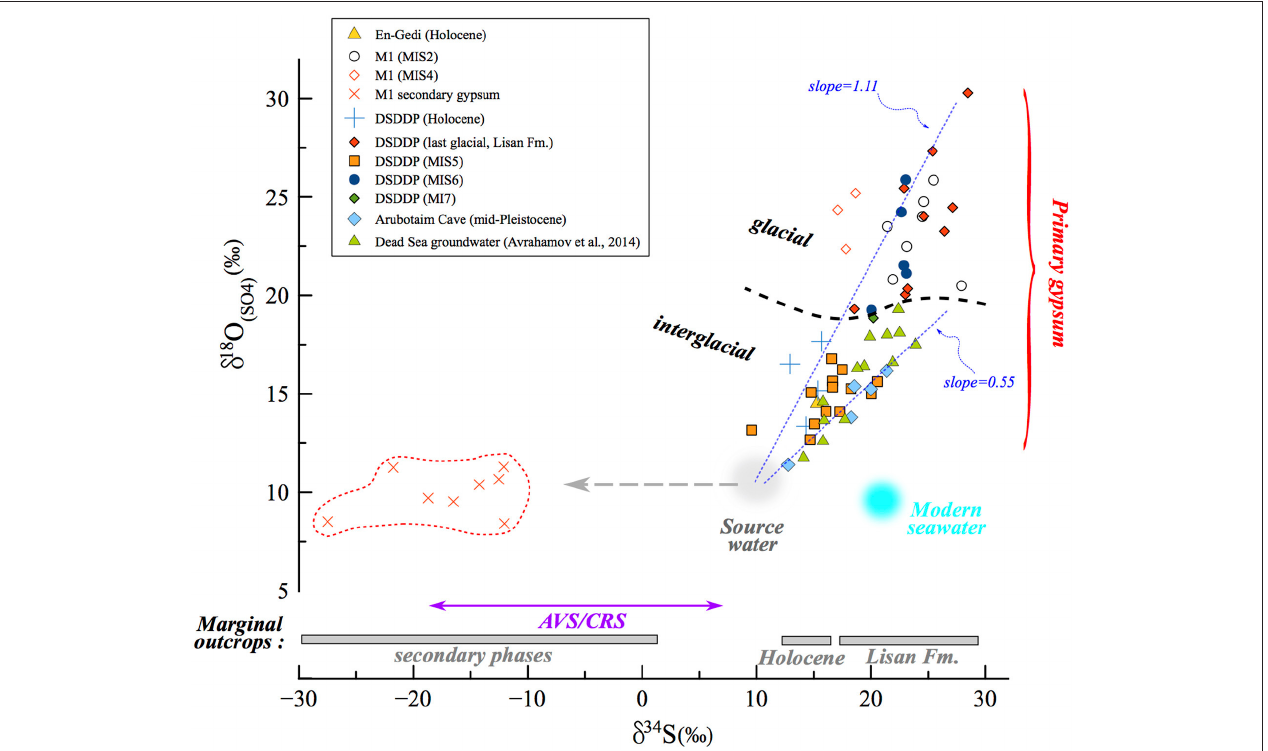
FIGURE 7 | δ 34 S vs. δ 18 O (SO4) in the Dead Sea lacustrine environment. The compositions of primary and secondary minerals branch out from the same source sulfate composition, that of influxing freshwater (gray circle). The correlation reveals a clear difference (marked by dashed black curve) between interglacial deposits and those associated with full glacial and deglacial stages. In the land-locked Dead Sea basin, the distribution and evolution patterns of δ 34 S and δ 18 O (SO4) are completely independent from the seawater composition (blue circle). In some samples only δ 34 S was measured (gypsum from marginal outcrops from Torfstein et al., 2008 and AVS/CRS from the DSDDP core), and the range of these data are given in the bottom part of the diagram. The slope of the δ 34 S vs. δ 18 O (SO4) has been shown to reflect the rate of microbial sulfate reduction, whereby the steeper the slope, the slower the rate. Accordingly, slopes calculated for interglacial periods (e.g., Amora Fm., Dead Sea groundwater) are systematically lower than those calculated for glacial period; two examples of linear regressions are presented (dashed blue curves): Amora Fm. with a slope of 0.55 and the glacial MIS2 samples yielding a higher slope of 1.11. This implies that the rate of microbial sulfate reduction processes was significantly slower during glacials relative to